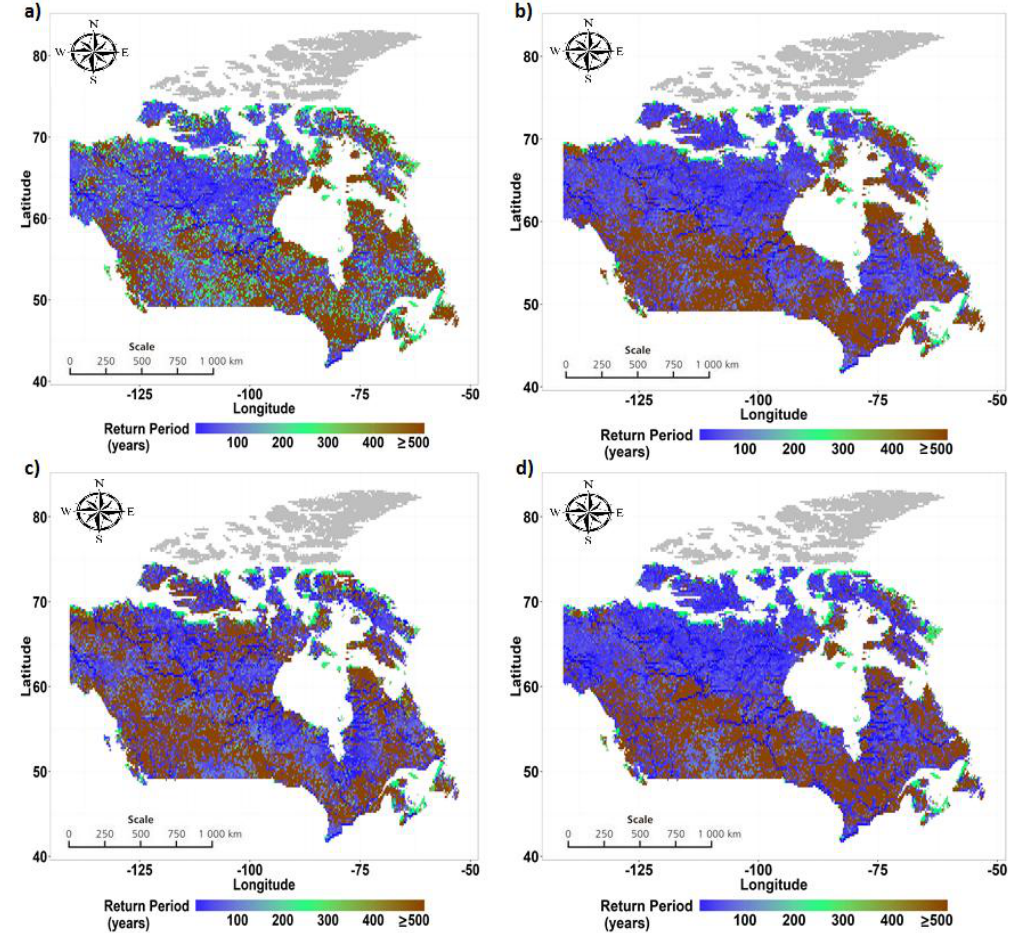
Figure 2. Future return periods of historical 250-year flood event for: ( a ) RCP 2.6; ( b ) RCP 4.5; ( c ) RCP 6.0; and ( d ) RCP 8.5. The results presented are GCM projections aggregated using the robust GCM median approach.